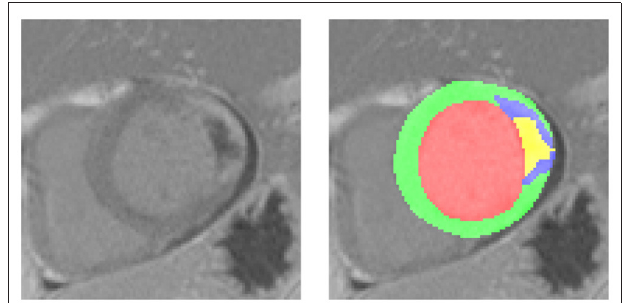
FIGURE 1 | A typical Delayed Enhancement MRI (DE-MRI) slice involving the myocardial infarction (MI) and the persistent microvascular obstruction (PMO). On the left the cropped short-axis DE-MRI covering the whole left ventricle, on the right the corresponding masks of normal myocardium (green), MI (blue, PMO exclusive) and PMO (yellow). The PMO is semi-wrapped by the MI and contacts the